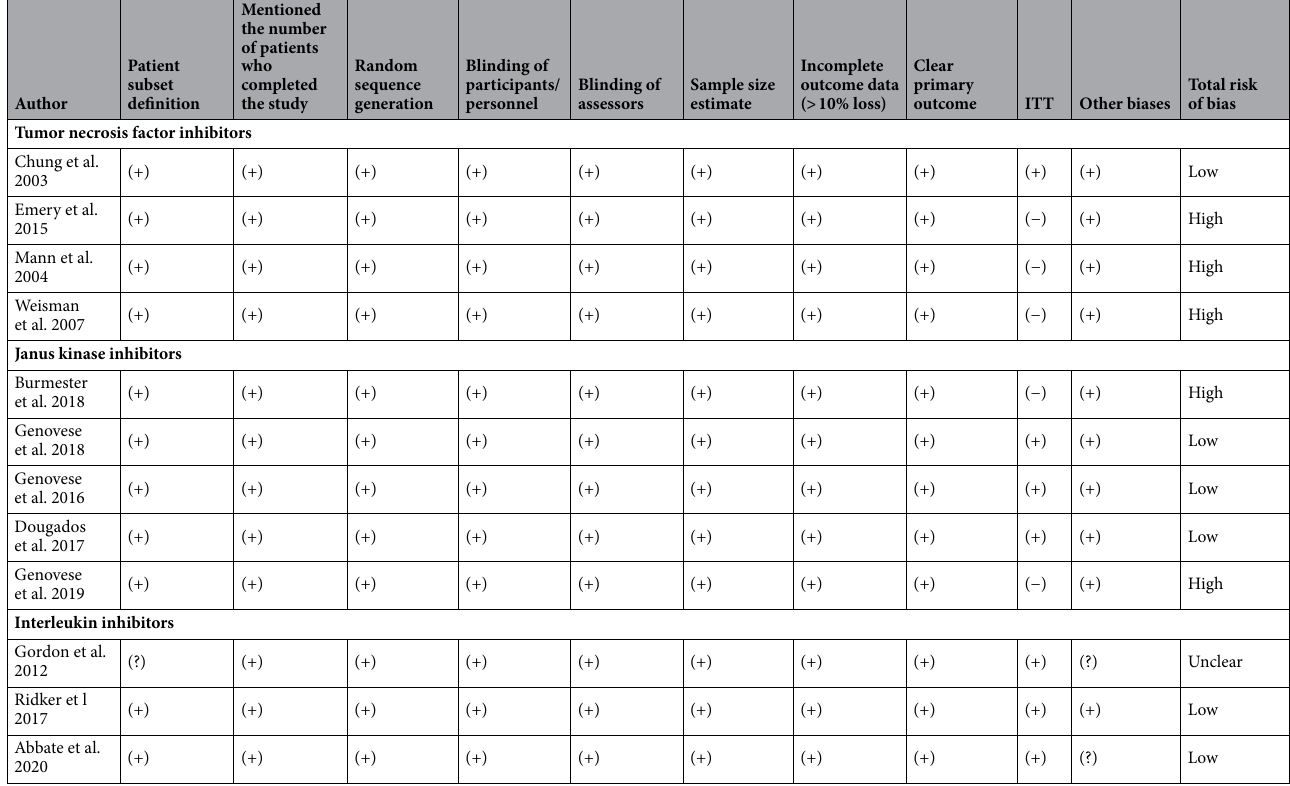
Table 3. Quality assessment summary of all included